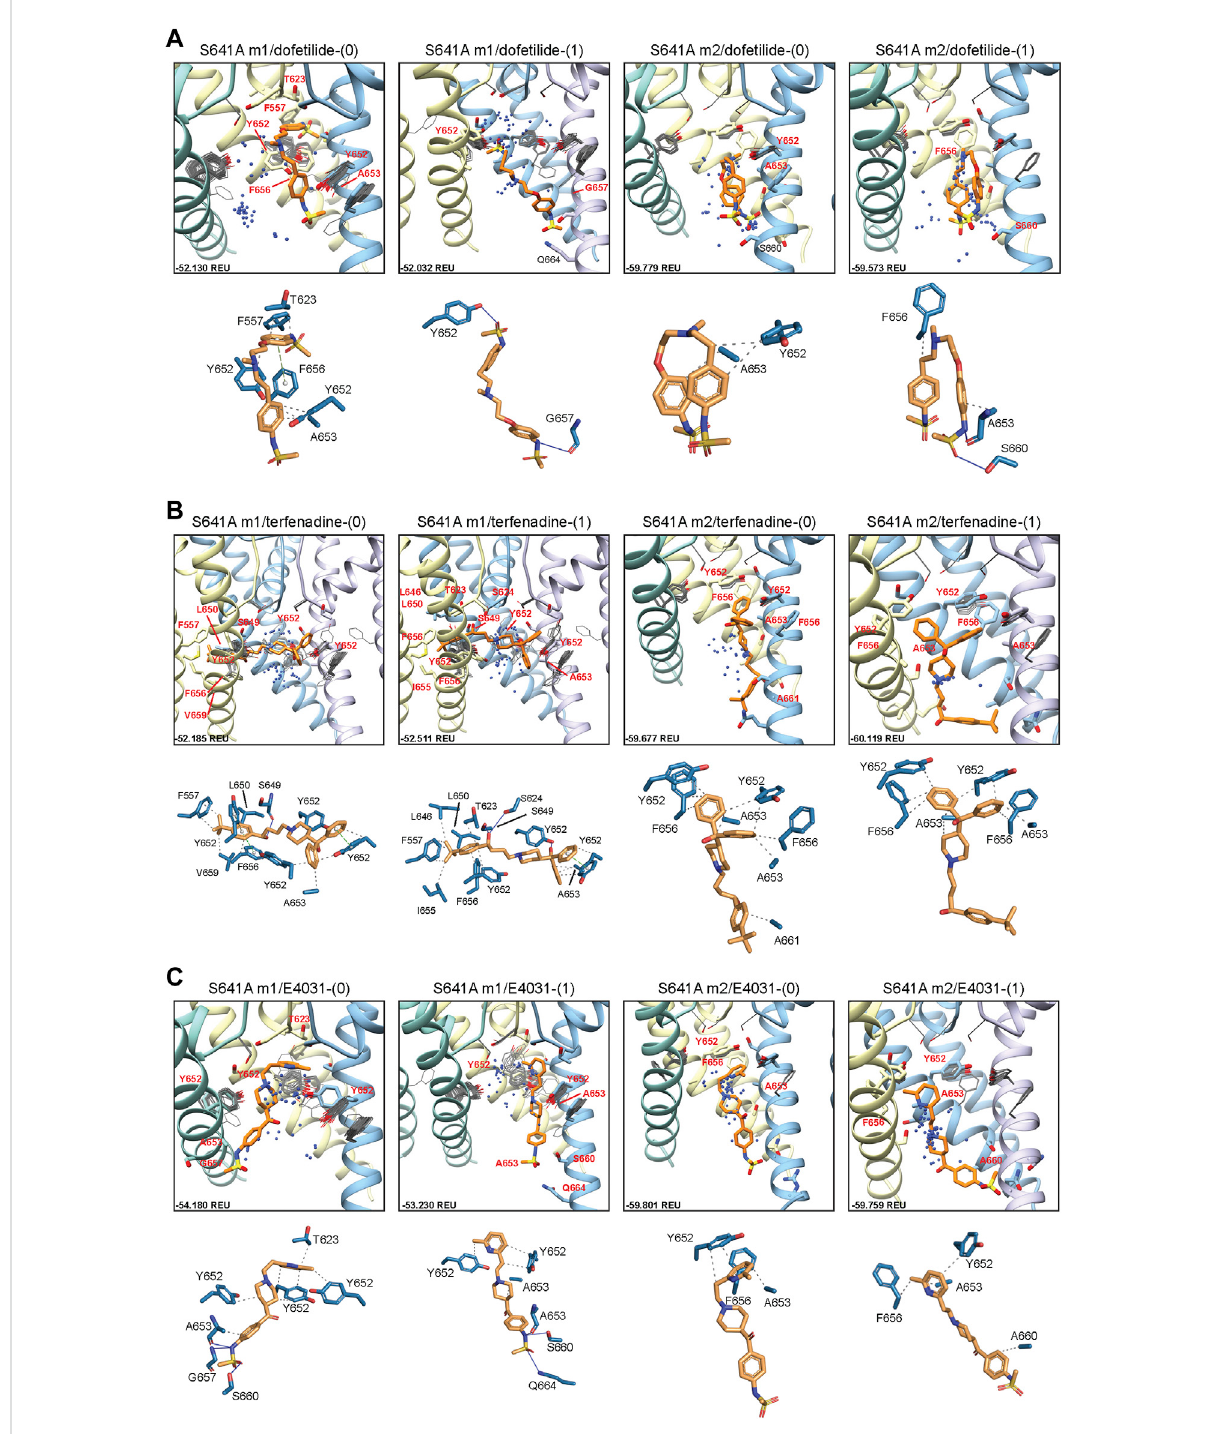
FIGURE 4 hERG S641A drug docking results for (A) dofetilide, (B) terfenadine and (C) E4031. Boxes represent top 50 scoring structures, with top-scoring structure as orange sticks (for carbon atoms) and remaining structures as blue centroids representing central nitrogen/charge group of the respective compound. Atoms, residues, and chains are shown and colored as in Figure 2. Rosetta ligand interface score for each top-scoring structure and PLIP for top-scoring poses are shown as in Figure 2 and summarized in Supplementary Table